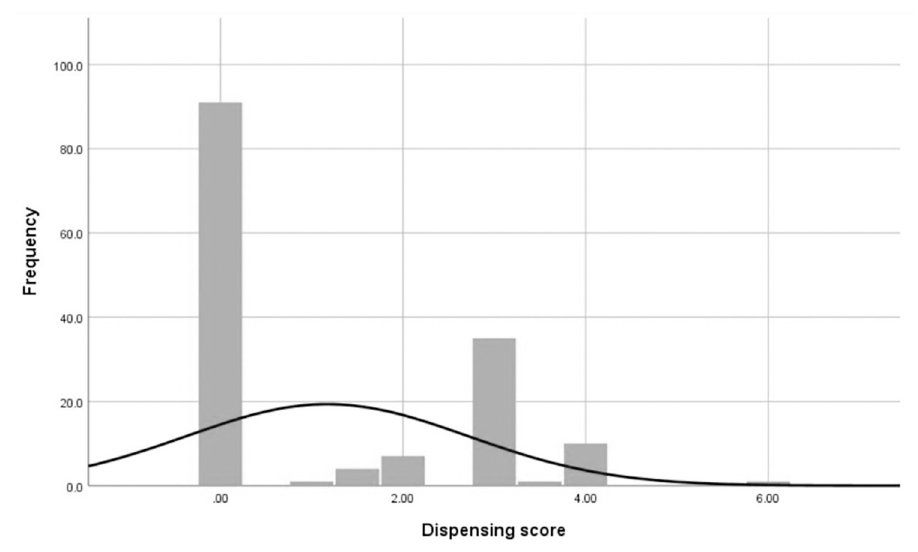
Fig 2. Distribution of dispensing score.